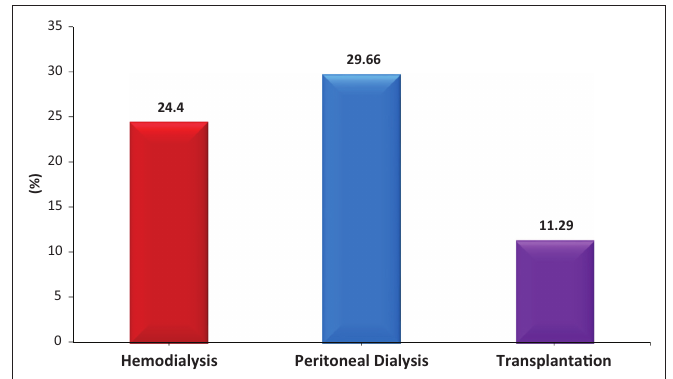
Figure 2. Coronavirus disease 2019 mortality rate in kidney replacement therapy modalities.